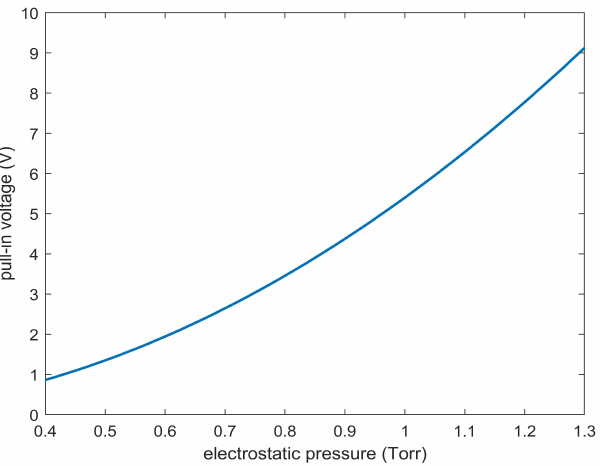
Figure 10. Pull-in voltage as function of the distance d .